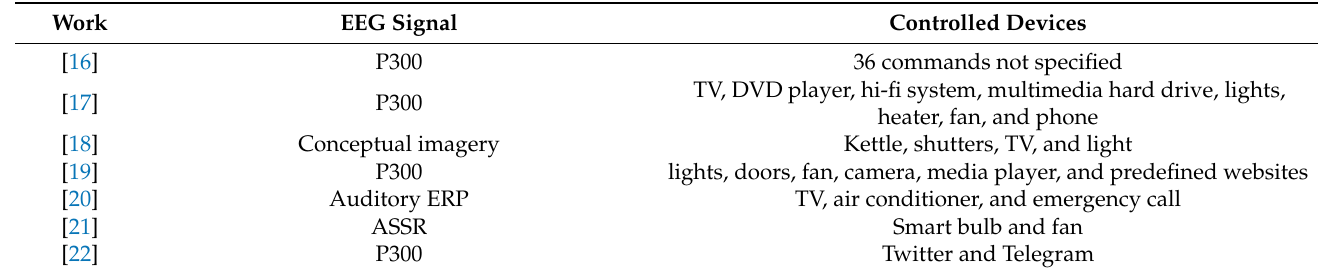
Table 1. EEG-based BCI proposals that include daily use